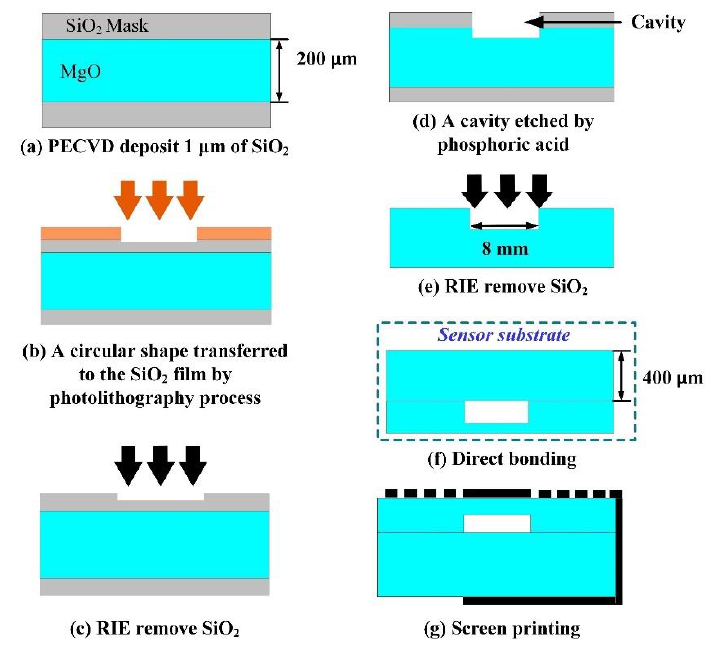
Figure 2. The fabrication process of the single-crystal MgO LC wireless passive pressure sensor.